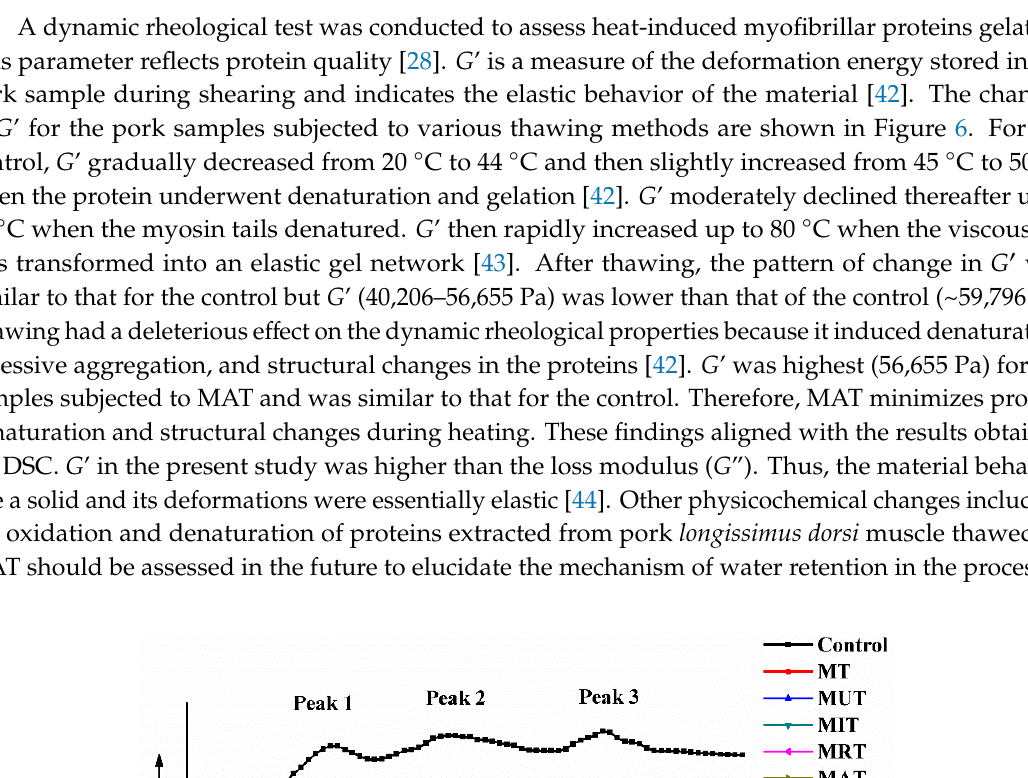
Figure 6. Changes in dynamic storage modulus ( G’ Pa) of pork samples under six different thawing conditions. MT: Microwave thawing (100 W); MUT: Microwave combined with ultrasonic thawing; MIT: Microwave combined with 35 °C water immersion thawing; MRT: Microwave combined with 4 °C refrigeration thawing; MAT: Microwave combined with air convection thawing; MWT: Microwave combined with running water thawing.